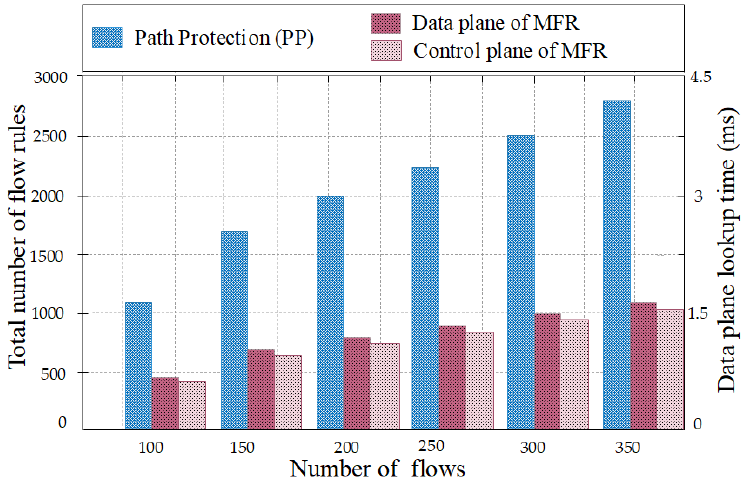
Figure 10. Lookup time based on the number of flow